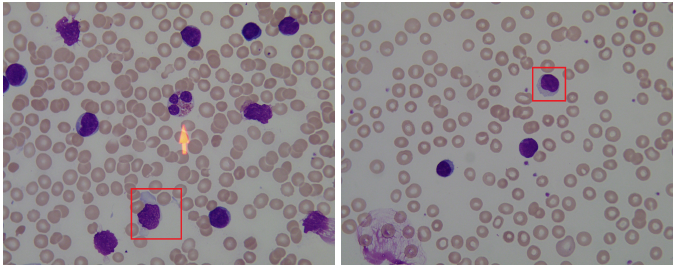
Figure 12. Example of images with a pixel-wise segmentation accuracy lower than the average. The reason is related to the presence of a light cytoplasm, which makes segmentation harder than the nucleus region. From left to right: Image Numbers 9 and